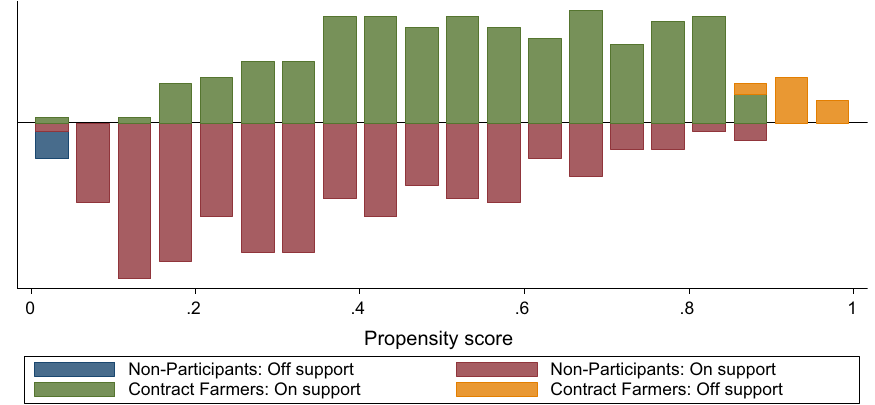
Fig. 1 Propensity score distribution and common support for propensity score